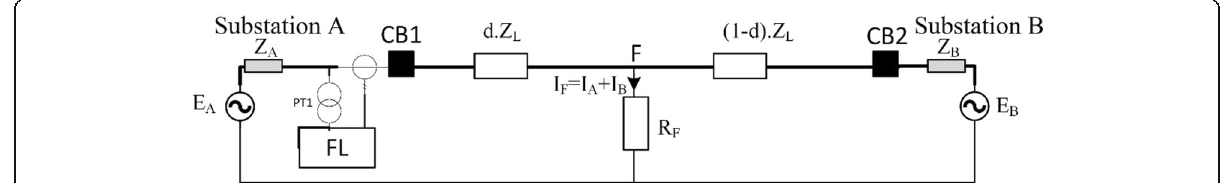
Fig. 2 Impedance based fault location with the source at two